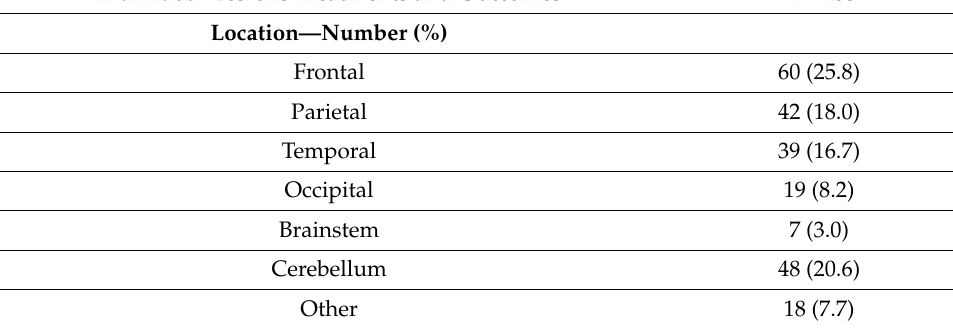
Table 3. Summary of treatments and volumetric outcomes of the 233 individual metastases. HFRT = hypofractionated radiotherapy. * A negative value for volume reduction indicates volume expan- sion. ** Pseudoprogression.